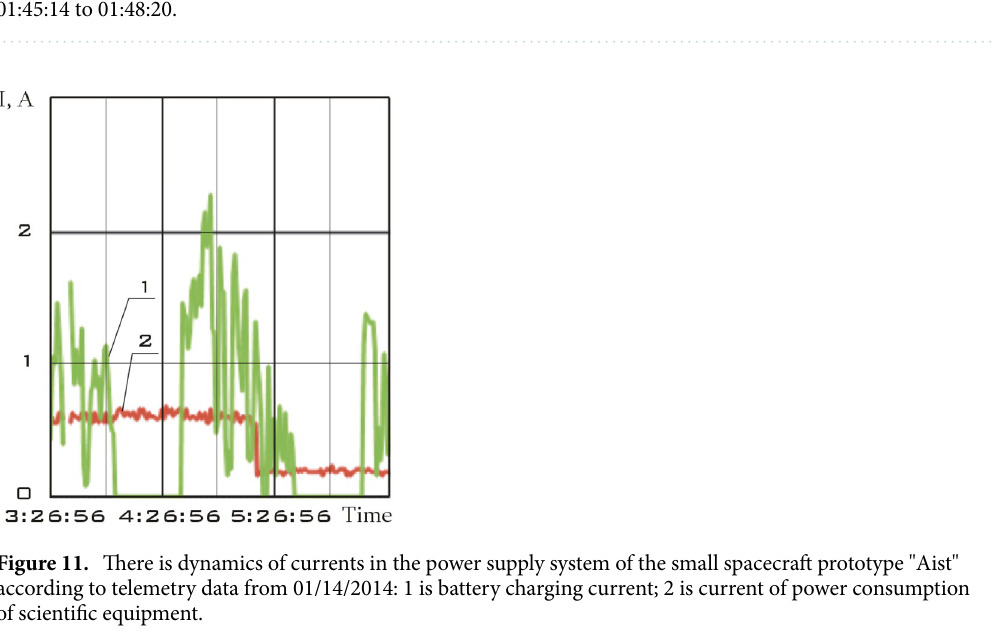
Figure 10. There are modulus of the disturbing moment in the coordinate system CXYZ. 01/11/2014 from 01:45:14 to 01:48:20.